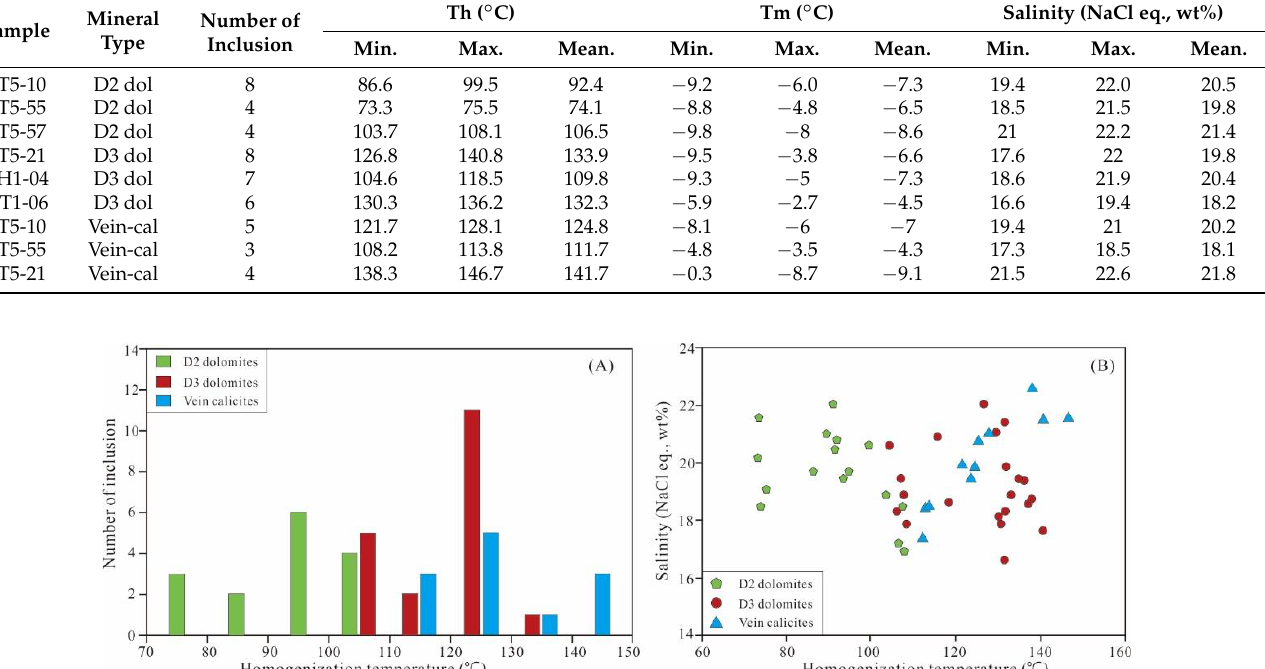
Table 3. Fluid inclusion data for D2 and D3 dolomites, and vein calcite from the Cambrian successions in the Bachu area, Tarim Basin.